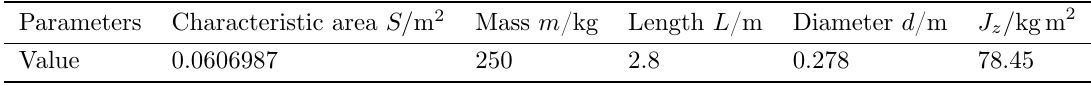
Table 2. Structure parameters of the missile body.